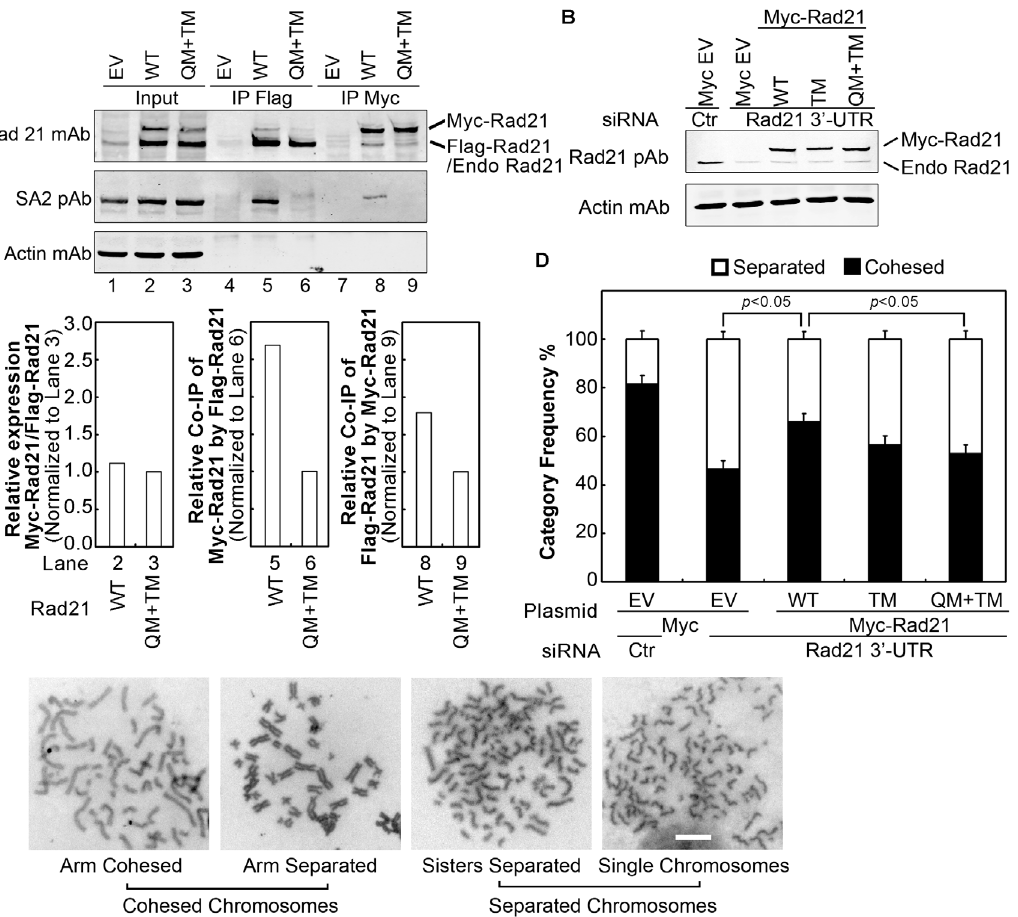
Figure 7. Reduced Rad21-Rad21 dimerization and defect in sister chromatid cohesion in cells expressing Rad21 with mutations on SA-binding motifs. (A) Co-IP of differentially tagged Rad21 with mutations on both NT and MP SA-binding motifs. Rad21 WT or mutants of QM + TM (see Figure 6D) were tagged with Flag or Myc on its N-terminus and expressed in 293 T cells. IP was performed with Flag mAb or Myc pAb conjugated agarose beads and immunoblotting was carried out. The bar graphs show the relative expression or co-IP level of Myc-Rad21 and Flag- Rad21. Rad21 WT bands were normalized using respective Rad21 QM + TM mutant bands. (B-D) Rad21 mutants cannot rescue the premature separation of sister chromatids caused by Rad21 knockdown. 293 T cells were treated with Rad21 3 9 -UTR siRNA or a control (Ctr) siRNA for 24 h before Myc-Rad21 WT or mutant plasmids was transfected. The knockdown of endogenous Rad21 and the expression of Myc-Rad21 were analyzed by Western blot using Rad21 pAb (B). Metaphase chromosome spread was performed and the status of sister chromatid cohesion was analyzed according to the categories shown in (C). About 100 mitotic cells were counted for each treatment. The frequency of mitotic cells was calculated and plotted in (D). EV, empty vector; WT, wild Type; QM, quadruple mutant R69A K70A K72A Y73A; TM, triple mutant L385A F389A T390A. Bar size=10 m m. Values were compared using Student’s t -test.